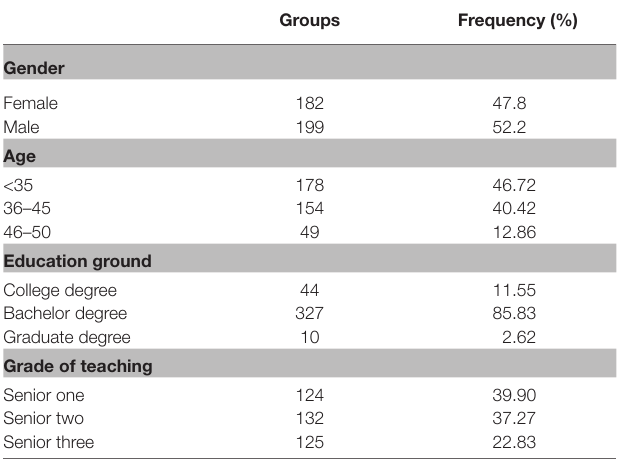
TABLE 1 | Socio-demographic characteristics of the participants ( n = 381). Groups